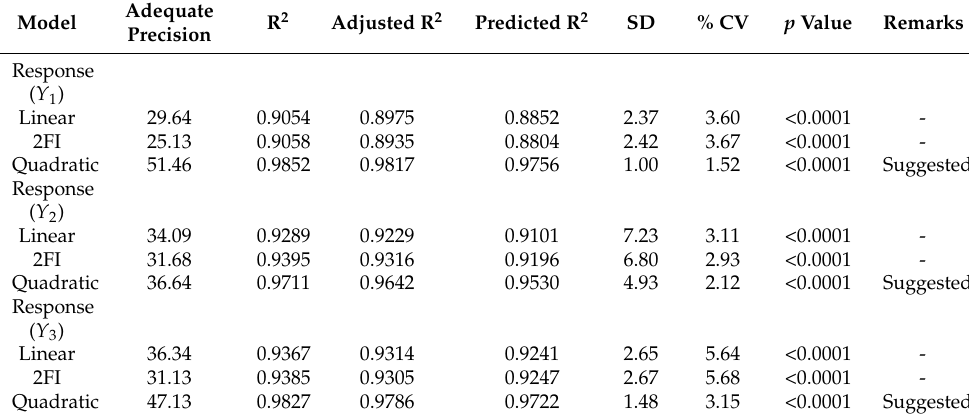
Table 3. Regression analysis results for the response